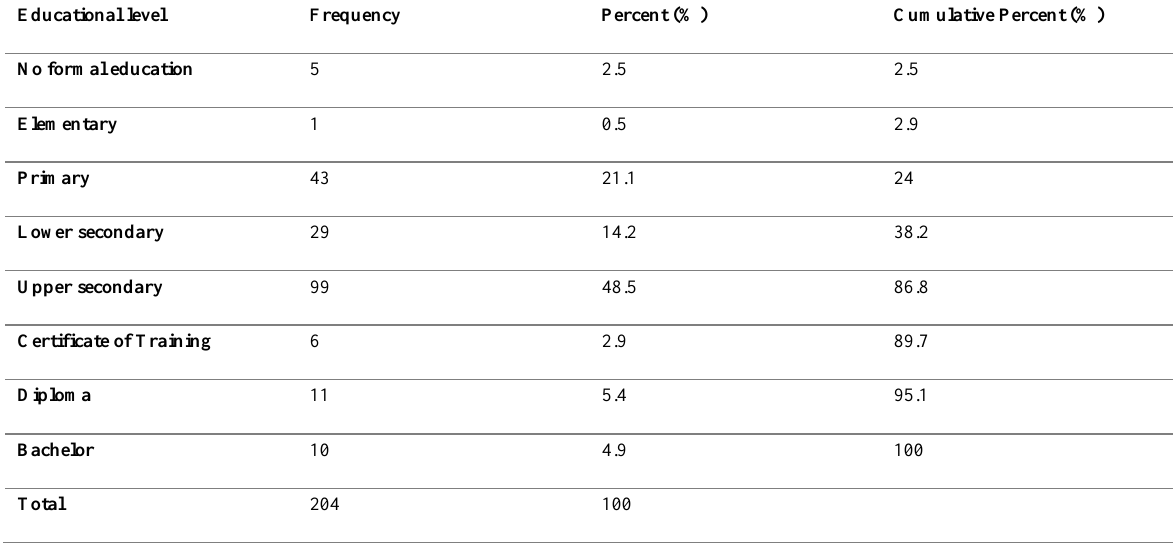
Table 3: Educational Qualification of Participants before Migrating to Urban